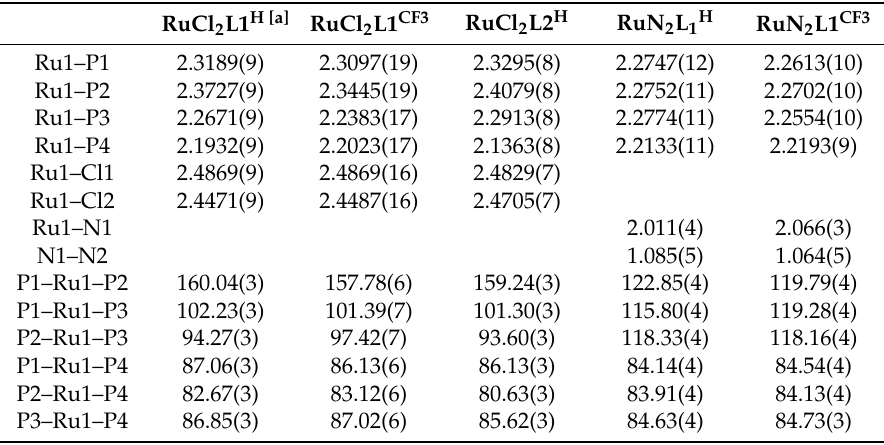
Table 1. Selected bond lengths (Å) and angles ( ◦ ) for Ru L complexes.